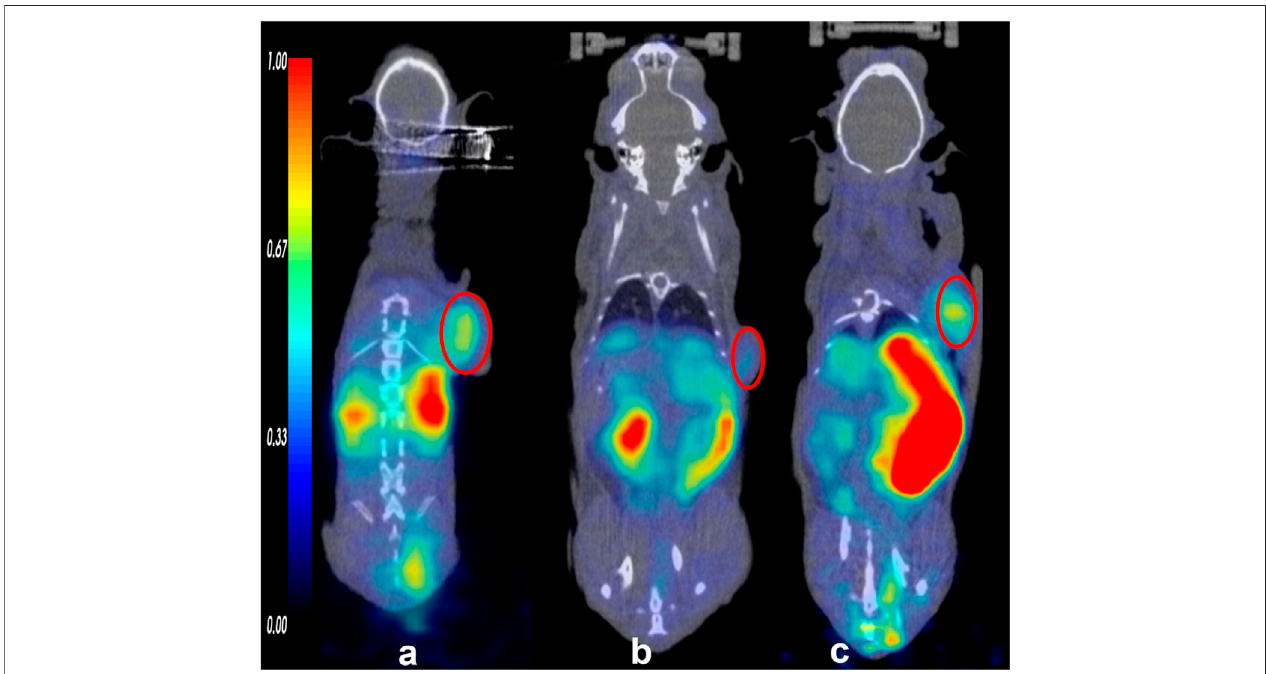
FIGURE 2 | The small animal PET/CT imaging of the tracers ( 68 Ga) Ga-DOTA-FAPI-04 (A) , 11 C-RJ1101 (B) , and 11 C-RJ1102 (C) at 60 min. And the tumor was indicated by the red circle.